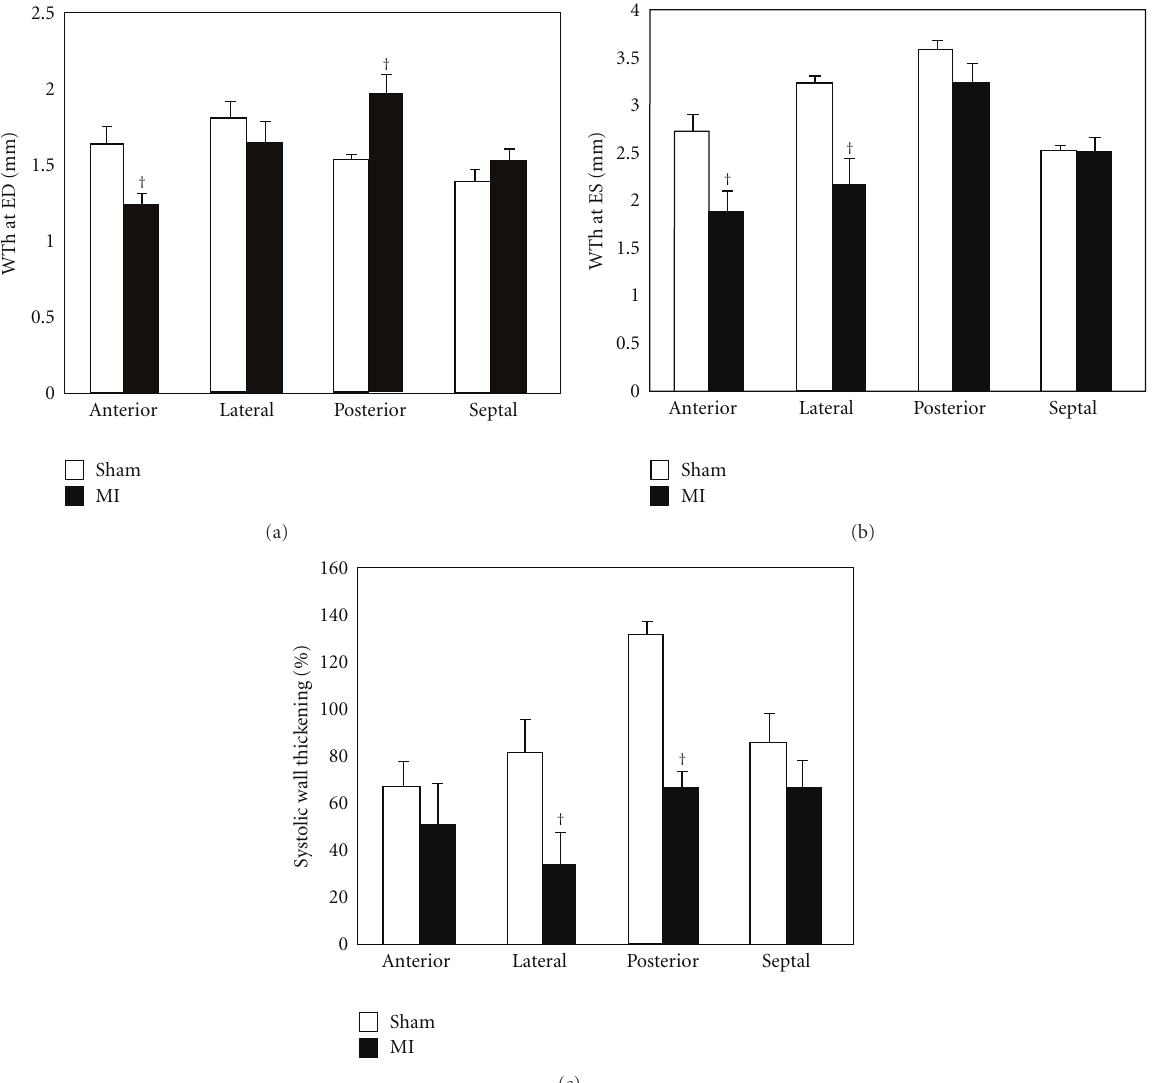
Figure 6: Analyses of regional LV function 4 weeks after surgery. Significant wall thinning occurs at ED in anterolateral regions while the posterior region demonstrates significant wall thickening (a). At ES, significant wall thinning is observed in anterior and lateral regions, while a modest decrease is evident in the posterior region (b). While all four regions show reduction in systolic wall thickening, it is only significant in the lateral and posterior regions (c). † P < 0 . 05 versus week 4